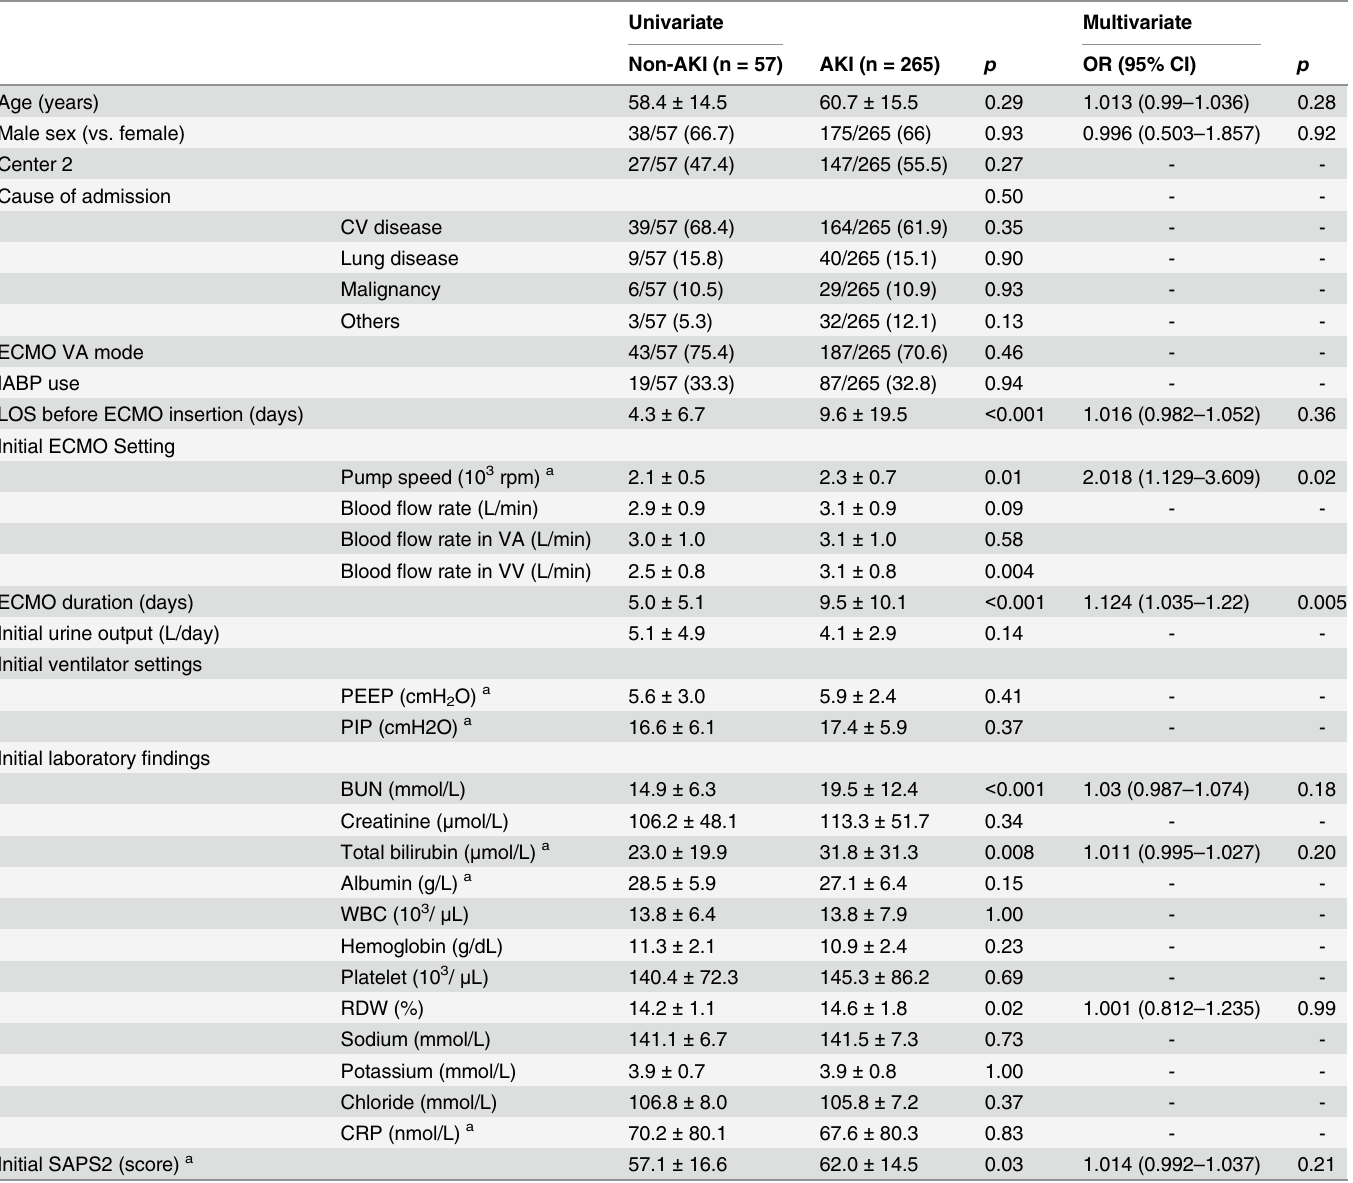
Table 5. Odds ratios for